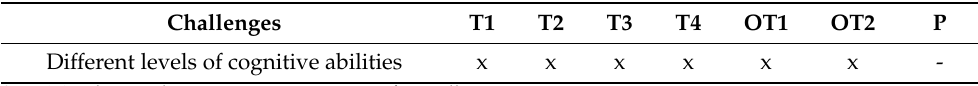
Table 5. Different levels of cognitive abilities of autism children.